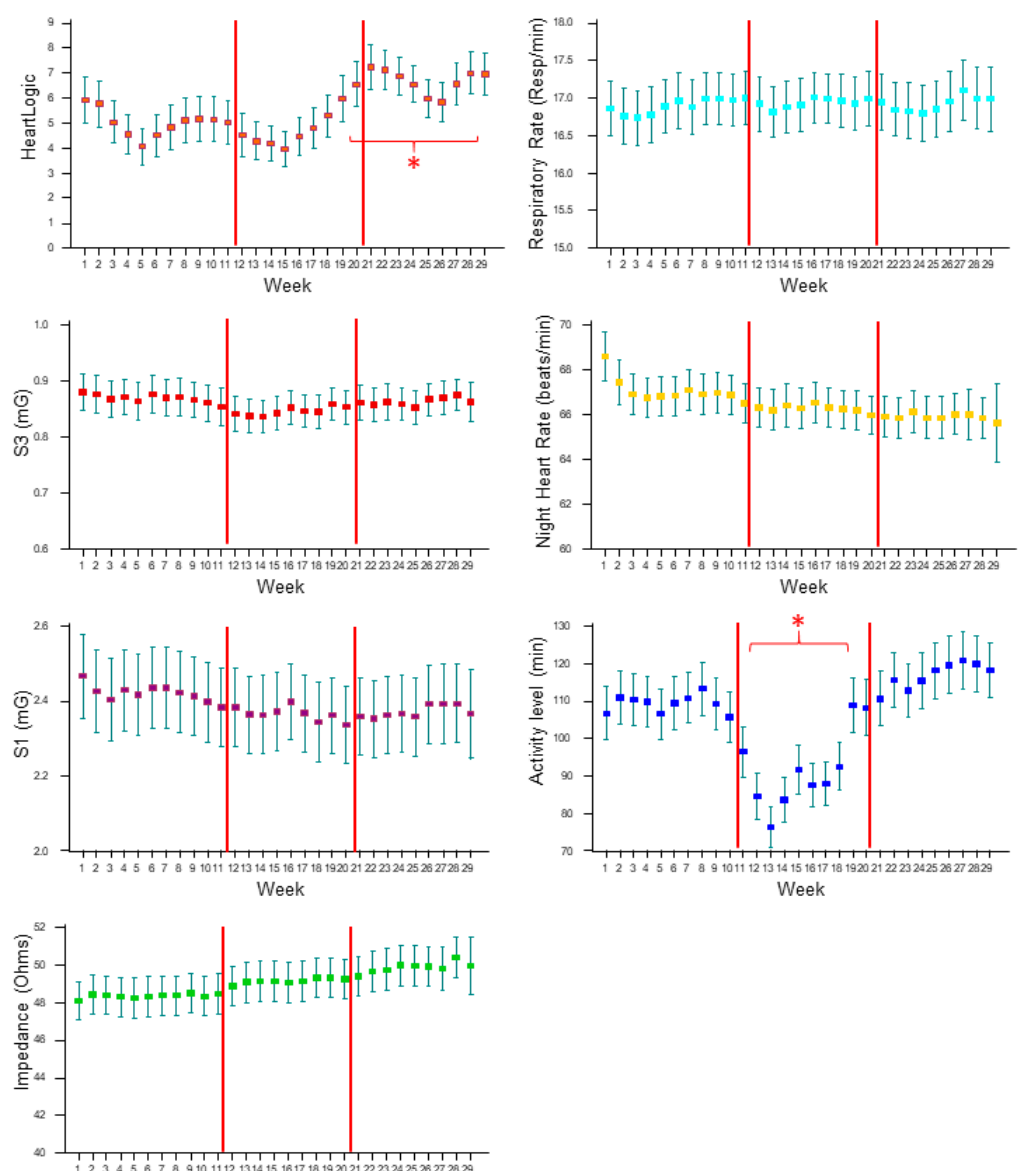
Figure 1. Weekly averages (with standard deviation) of the HeartLogic combined index and all physiologic parameters collected by the devices from 1 January to 19 July. The period was divided in 3 phases: pre-lockdown (weeks 1–11), lockdown (weeks 12–20), post-lockdown (weeks 21–29). S1: First heart sound; S3: Third heart sound; *: p < 0.05 versus pre-lockdown average.